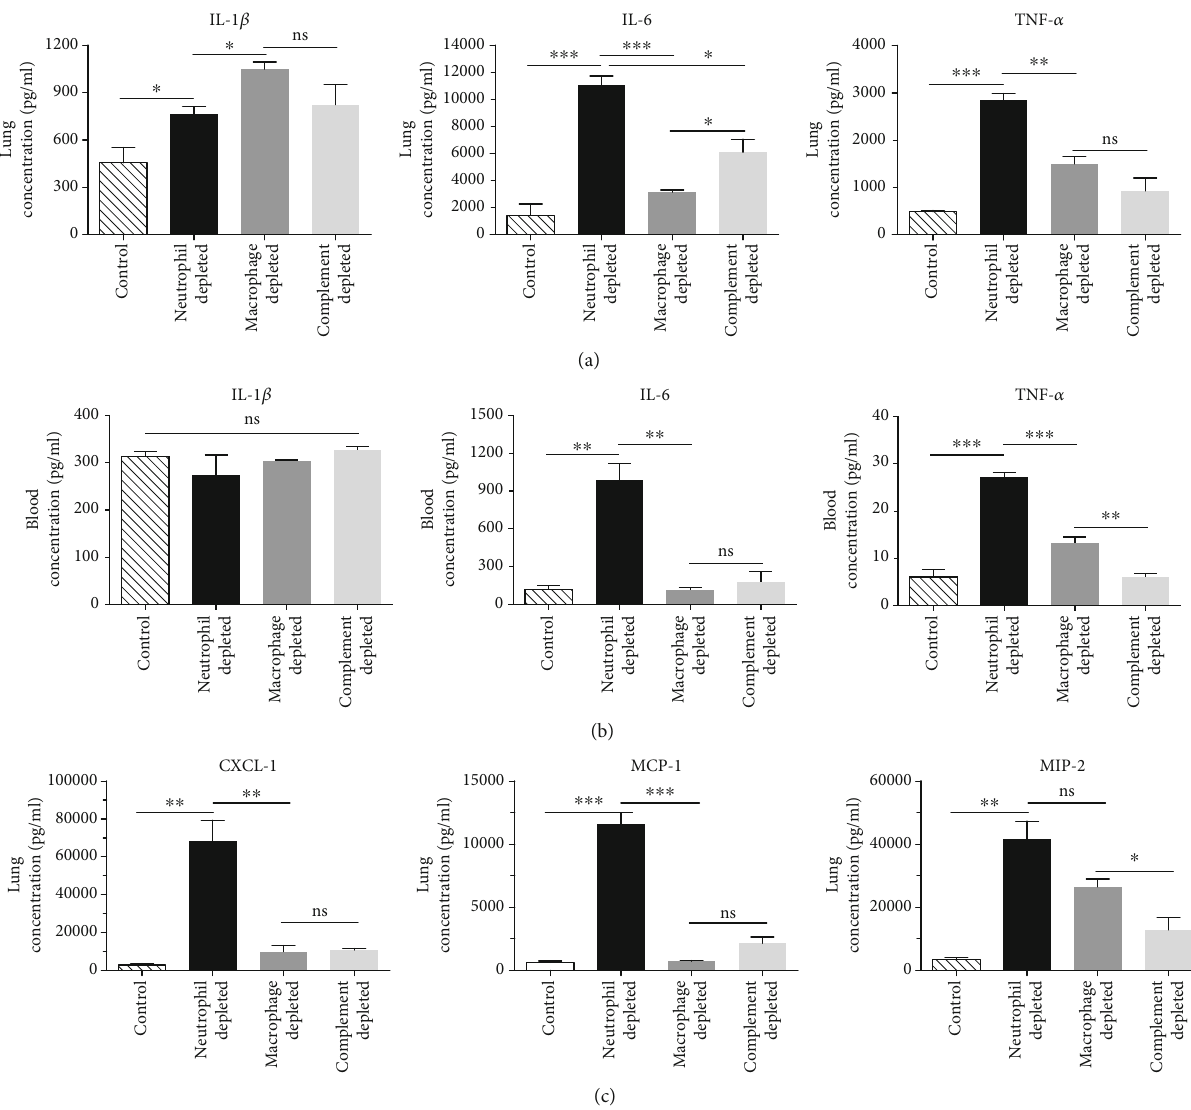
Figure 6: Depletion of innate immune e ff ectors resulted in increased levels of cytokines/chemokines in K. pneumoniae lung infection. (a) The levels of IL-1 β , IL-6, and TNF- α in the lung were detected by ELISA. (b) The levels of IL-1 β , IL-6, and TNF- α in blood samples were detected by ELISA. (c) The levels of MCP-1, MIP-2, and CXCL-1 in lung samples were measured by ELISA. These assays were performed in triplicate, and representative data from one experiment were expressed as means ± SEM . Statistical analyses were performed by Student ’ s t test. P < 0 : 05 ( ∗ ), P < 0 : 01 ( ∗∗ ), and P < 0 : 001 ( ∗∗∗ ) compared to each